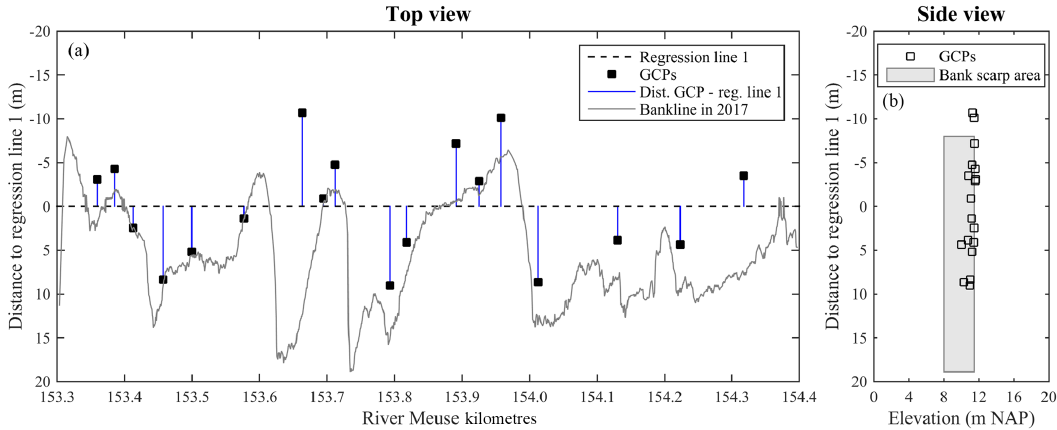
Figure 9. GCP horizontal distances to the regression line (a) and respective positions in potential rotation plane from the regression line (b) .